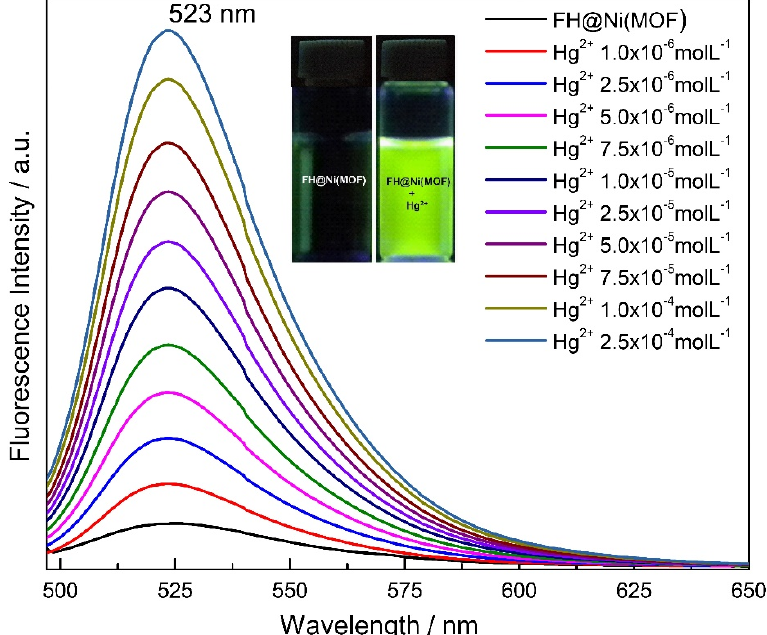
Figure 7. Changes in fluorescence emission spectra of FH@Ni(MOF) with the incremental addition of Hg 2+ (10 − 2 M) in water ( λ ex = 460 nm). Inset: fluorogenic changes in FH@Ni(MOF) upon the addi- tion of Hg 2+ in water upon illumination at 365